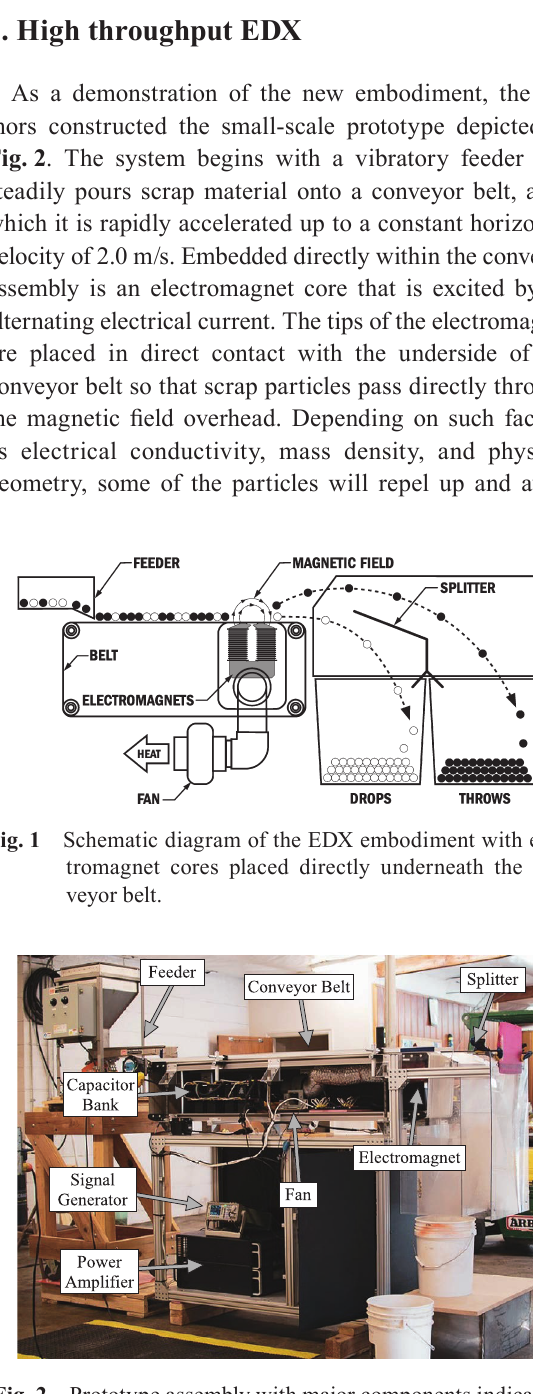
Fig. 2 Prototype assembly with major components